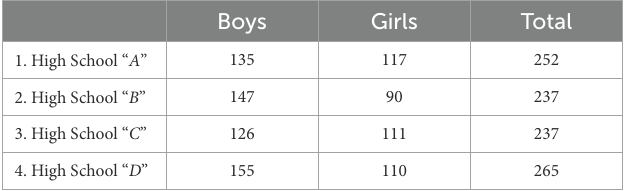
TABLE 1 Distribution of students by school.